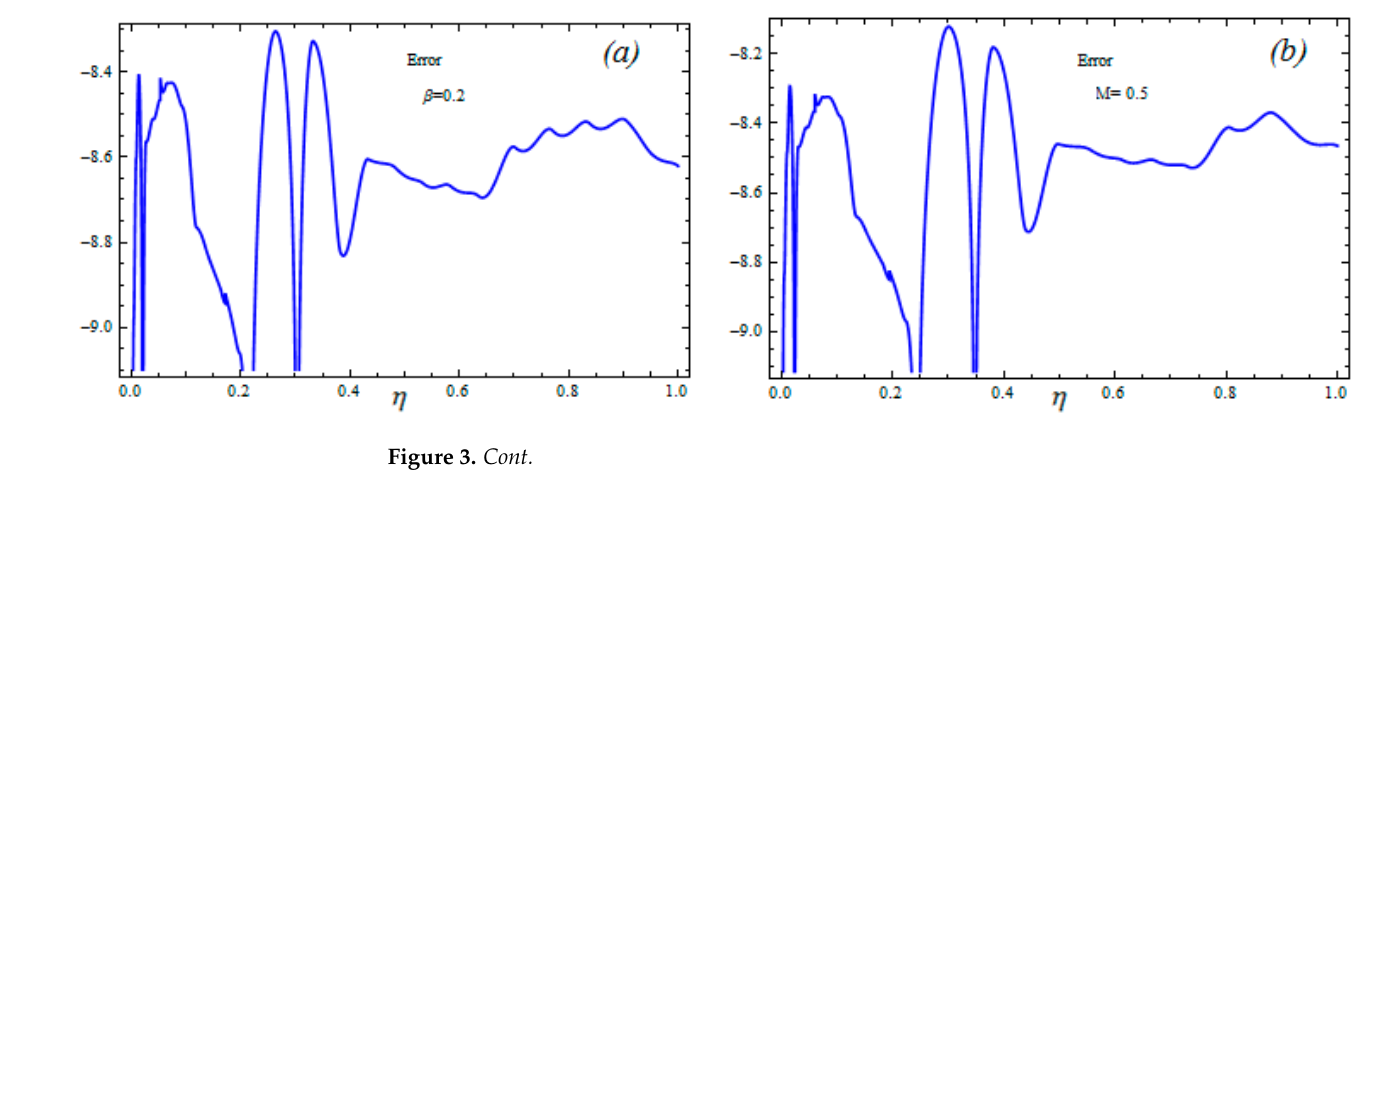
Figure 2. ( a ). A comparison of RK4 and NDSolve for ( a ) velocity field ( 𝑓 (cid:4593) ( 𝜂 ) ), ( b ) temperature field Θ ( 𝜂 ) , and ( c ) concentration profile 𝜙 ( 𝜂 ) .